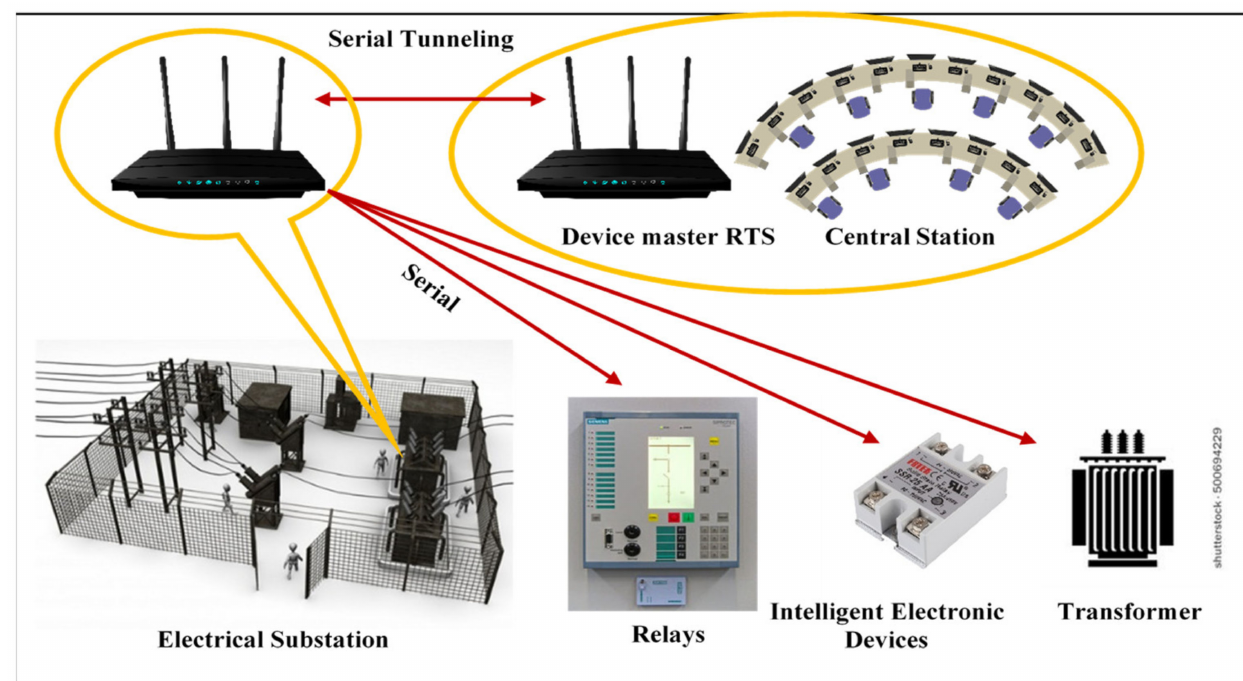
Figure 6. SCADA configuration for TNB control center in an electrical substation